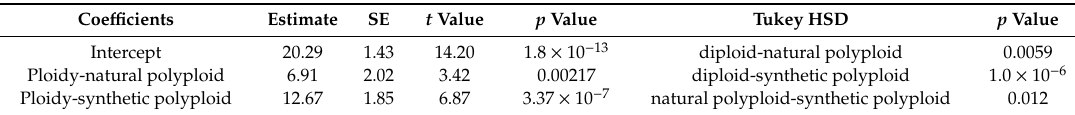
Table 1. Linear model results for width~ploidy.